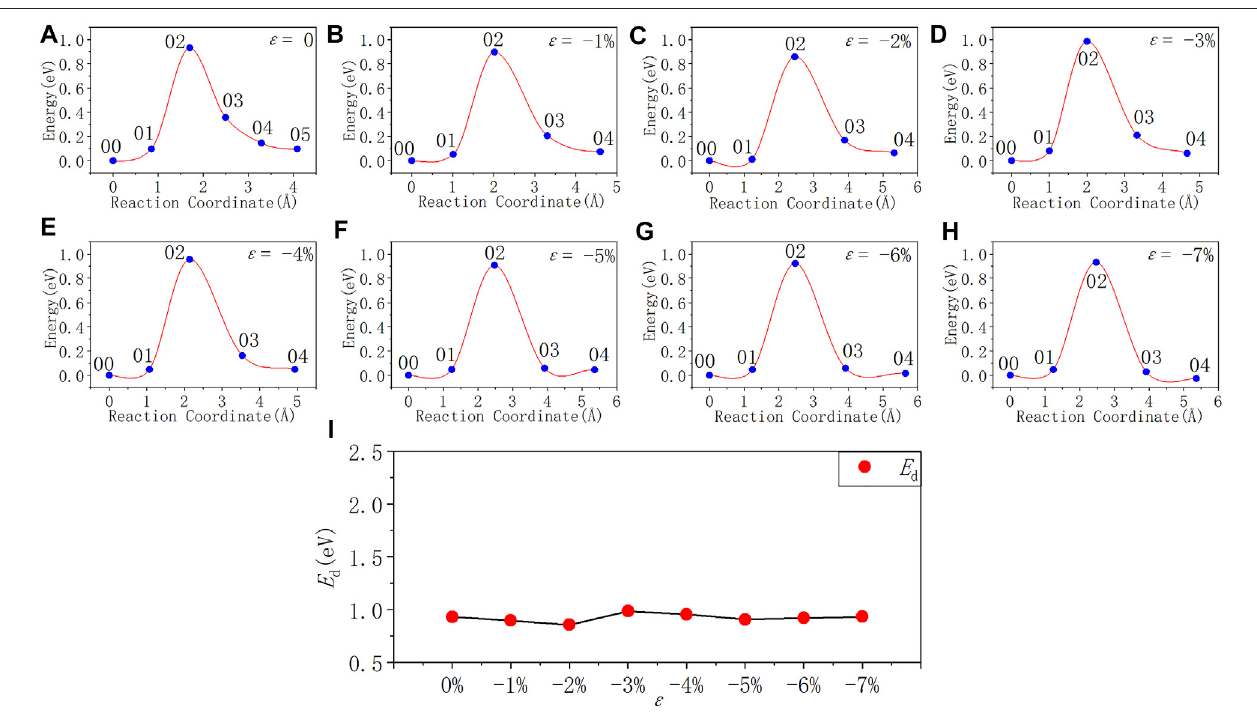
FIGURE9| Reactionenergycurvesandactivationenergypro fi lecurveofthe P b1 defectdepassivation; (A – H) exhibitdepassivationreactionenergycurvesundera compressive strain range of 0%~ − 7%, and (I) exhibits the activation energy pro fi le curve.